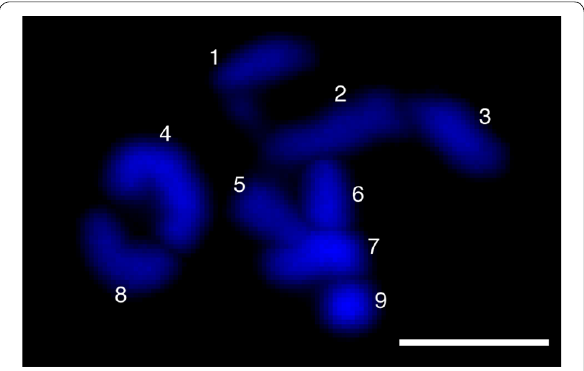
Fig. 4 Number of chromosomes in the gametophyte cells of M. angicava (N 9). The numbers indicate chromosomes. Scale = bar 2 µm. See also Additional file 1: Video =